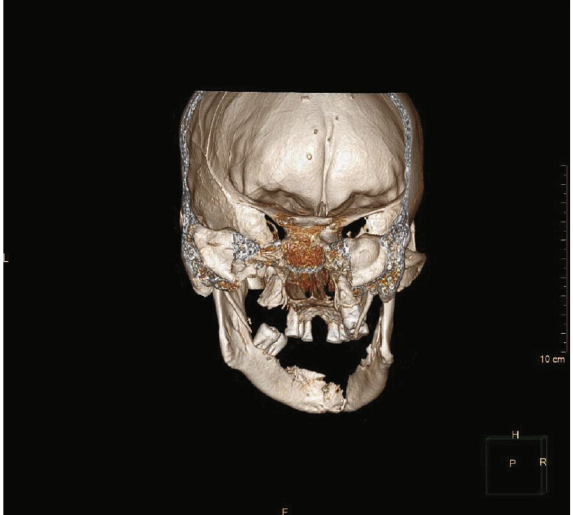
Figure 4: Lingual view of the same CT